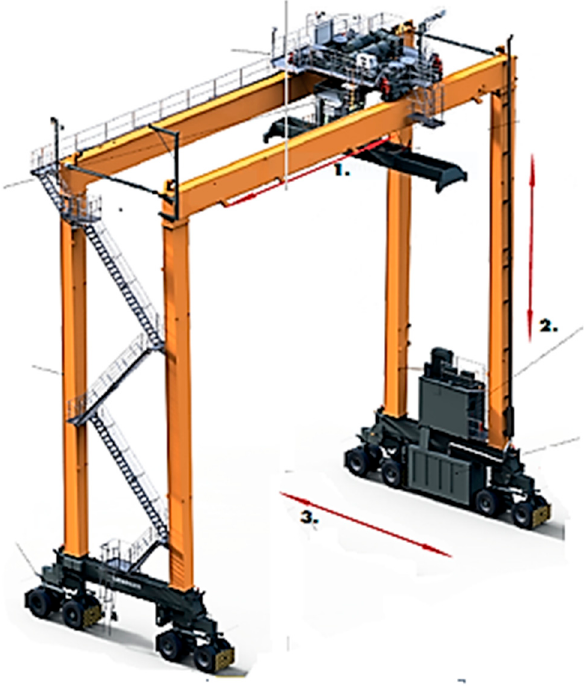
Figure 1. Directions of motions of rubber tire gantry crane (RTGC) ( 1 -Trolley, 2 -Hoist, 3 -Gantry).